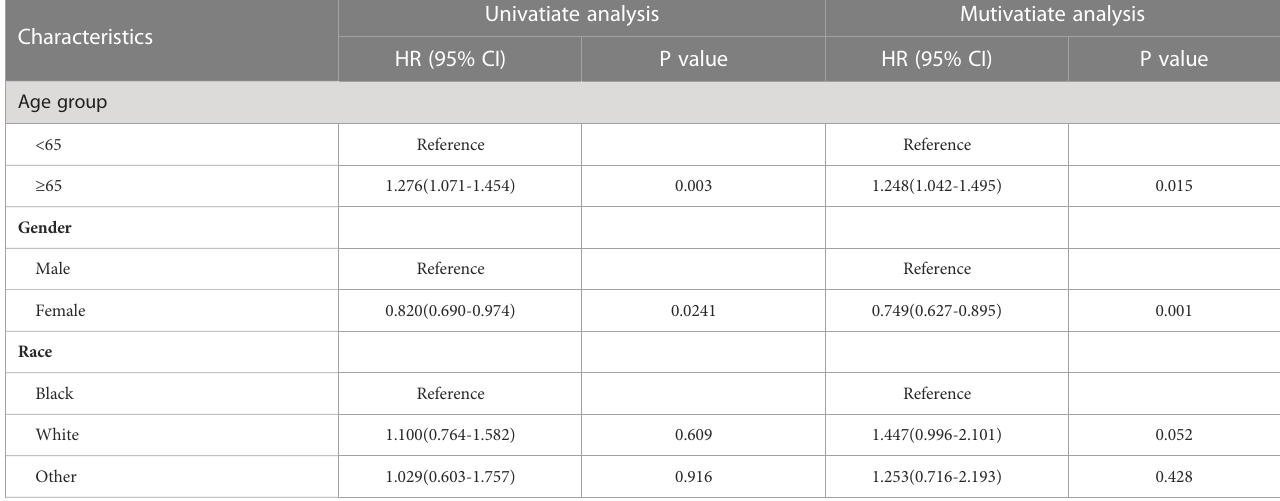
TABLE 3 Univariate and multivariable Cox regression for overall survival among SCLC patients with BM.